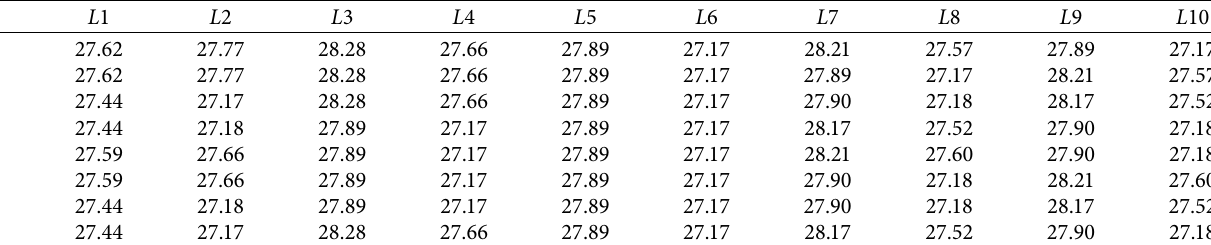
Table 3: Costs when a fight is delayed.